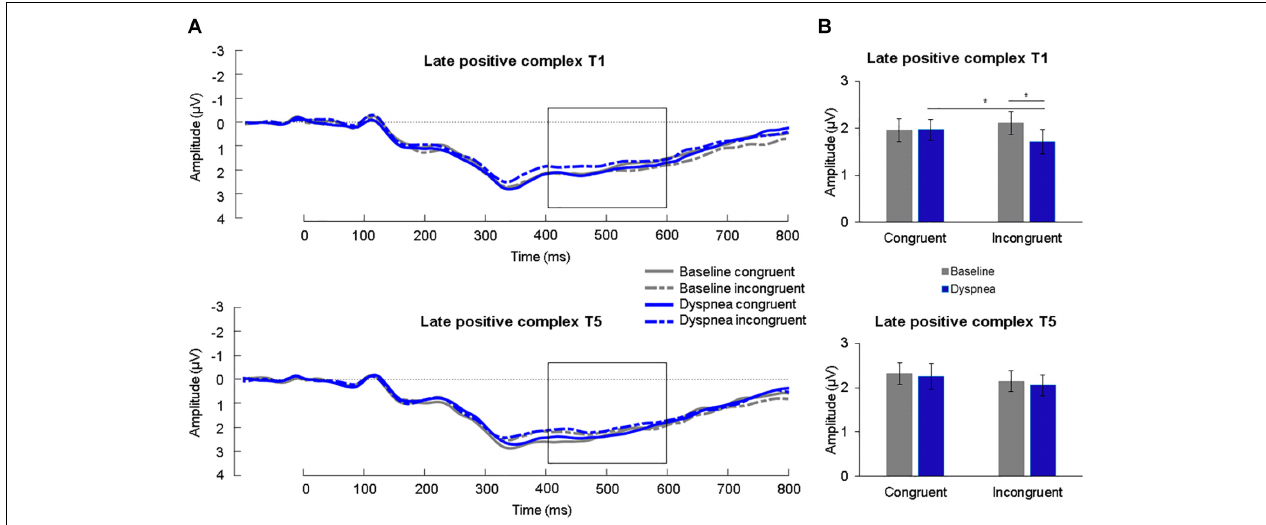
FIGURE 3 | (A) Grand average waveforms ( µ V) for each condition at centro-parietal sites for congruent and incongruent stimuli for T1 (upper panel) and T5 (lower panel). The late positive complex (LPC) is highlighted from 400 to 600 ms. (B) Mean ( SE ) amplitudes ( µ V) for each condition for the LPC for congruent and incongruent stimuli for T1 (upper panel) and T5 (lower panel). ∗ p < 0.05.